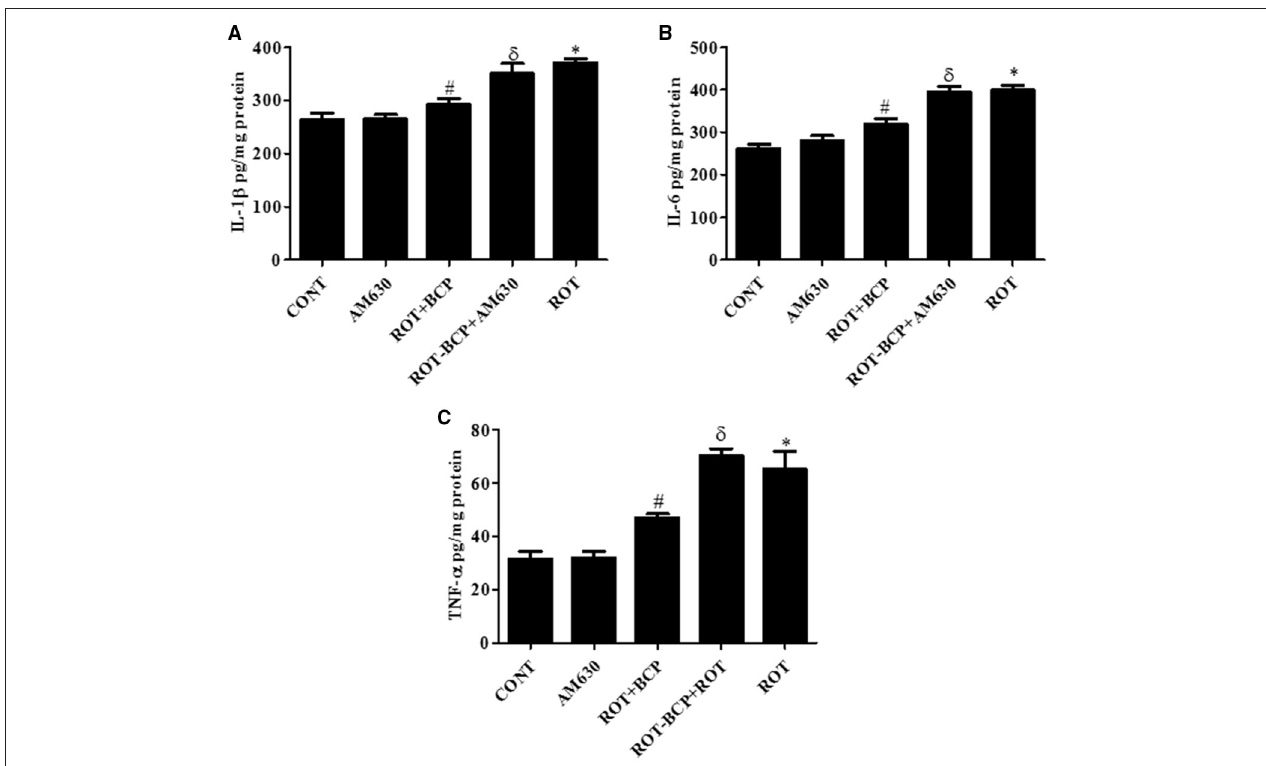
FIGURE 6 | The pro-inflammatory cytokines: IL-1 β , IL-6, and TNF- α were measured by enzyme linked immunosorbent assay (ELISA) in the midbrain. Values are expressed as mean ± SEM ( n = 6–8). The level of IL-1 β (A) , IL-6 (B) , and TNF- α (C) was significantly (* p < 0.05) increased in the ROT group when compared to the CONT group. Although, BCP supplementation significantly (# p < 0.05) decreased the ROT-induced increase of these proinflammatory cytokines in the ROT + BCP group. The ROT-BCP + AM630 group showed significantly ( δ p < 0.05) increased level of IL-1 β , IL-6, and TNF- α as compared to the ROT + BCP group. There is no significant difference in these cytokines between the CONT and the AM630-only